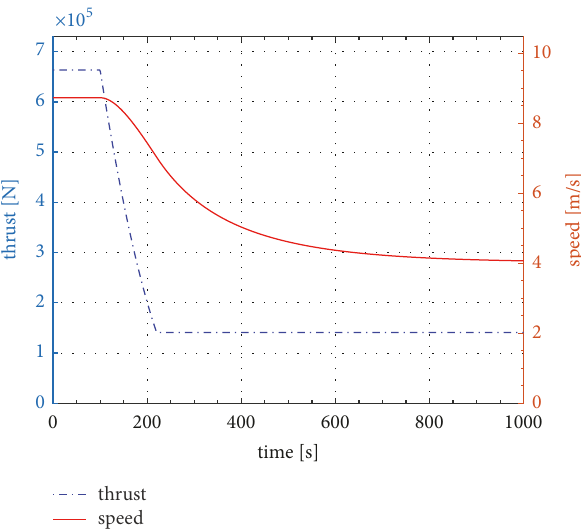
Figure9:Simulatedslowingdownofconsideredro-pax(rangefrom service speed 17 kn down to 4 kn ensuring ability to manoeuvre).